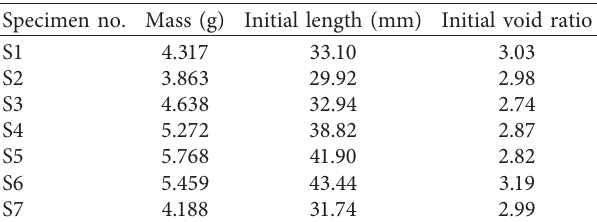
Figure 1: Confined compression test of the wood cylinder parallel to grain: (a) test setup for confined compression experiment; (b) typical crushing failure mode of wood cylinders. Table 1: The information of wood cylinder specimens for confined compression